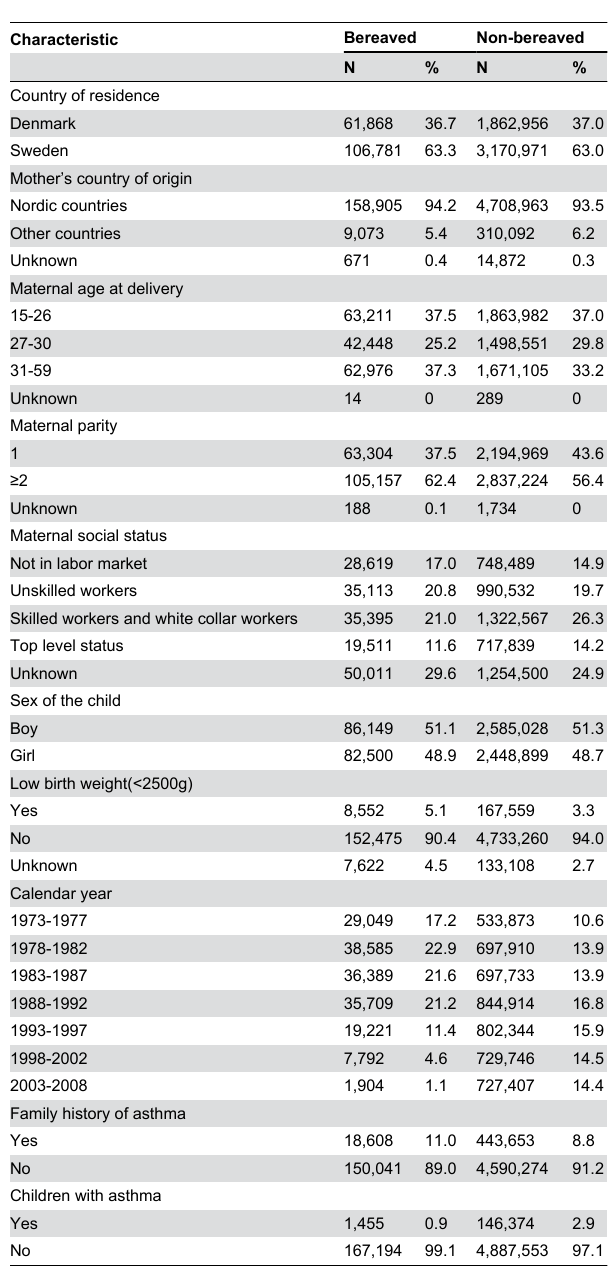
Table 1. Characteristics of the study population. Table 2. Hazard ratios (HRs) for asthma hospitalization in childhood according to